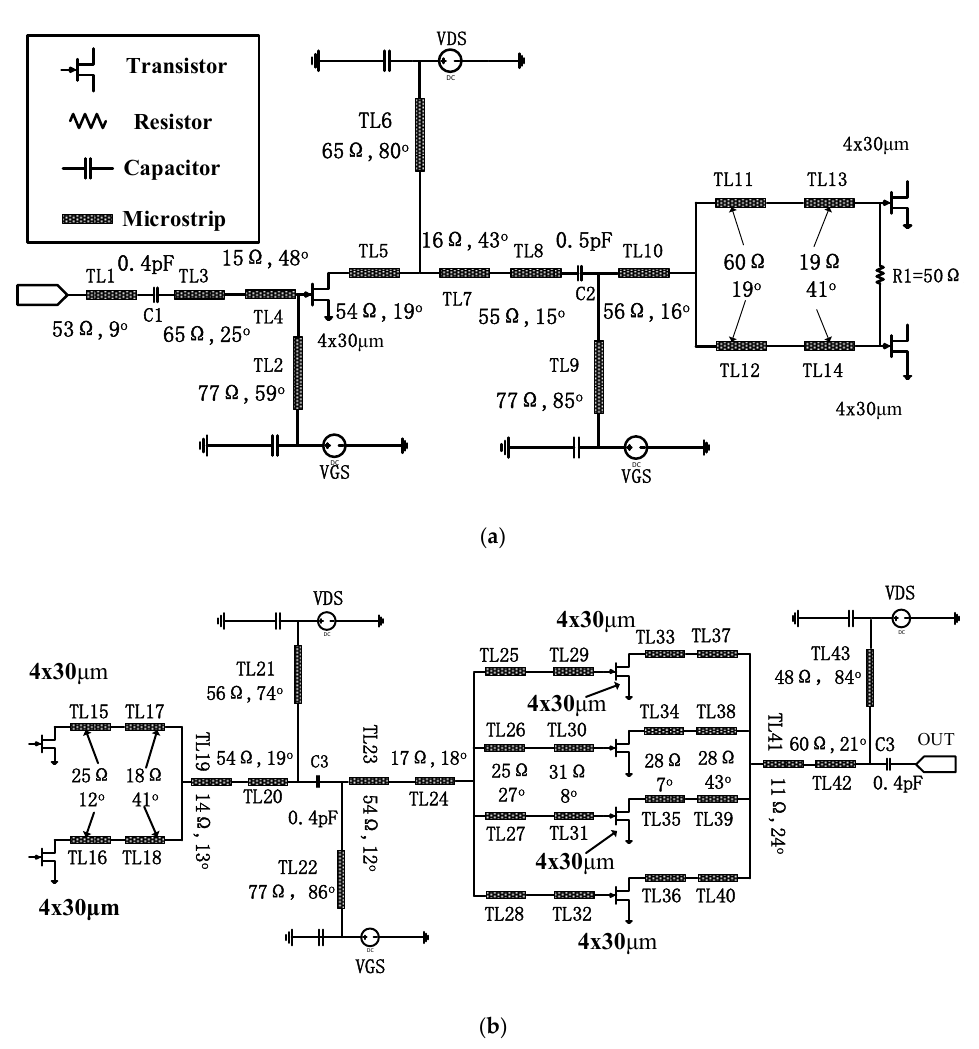
Figure 13. Schematic of W band amplifier: ( a ) Preceding stage and ( b ) Post stage.